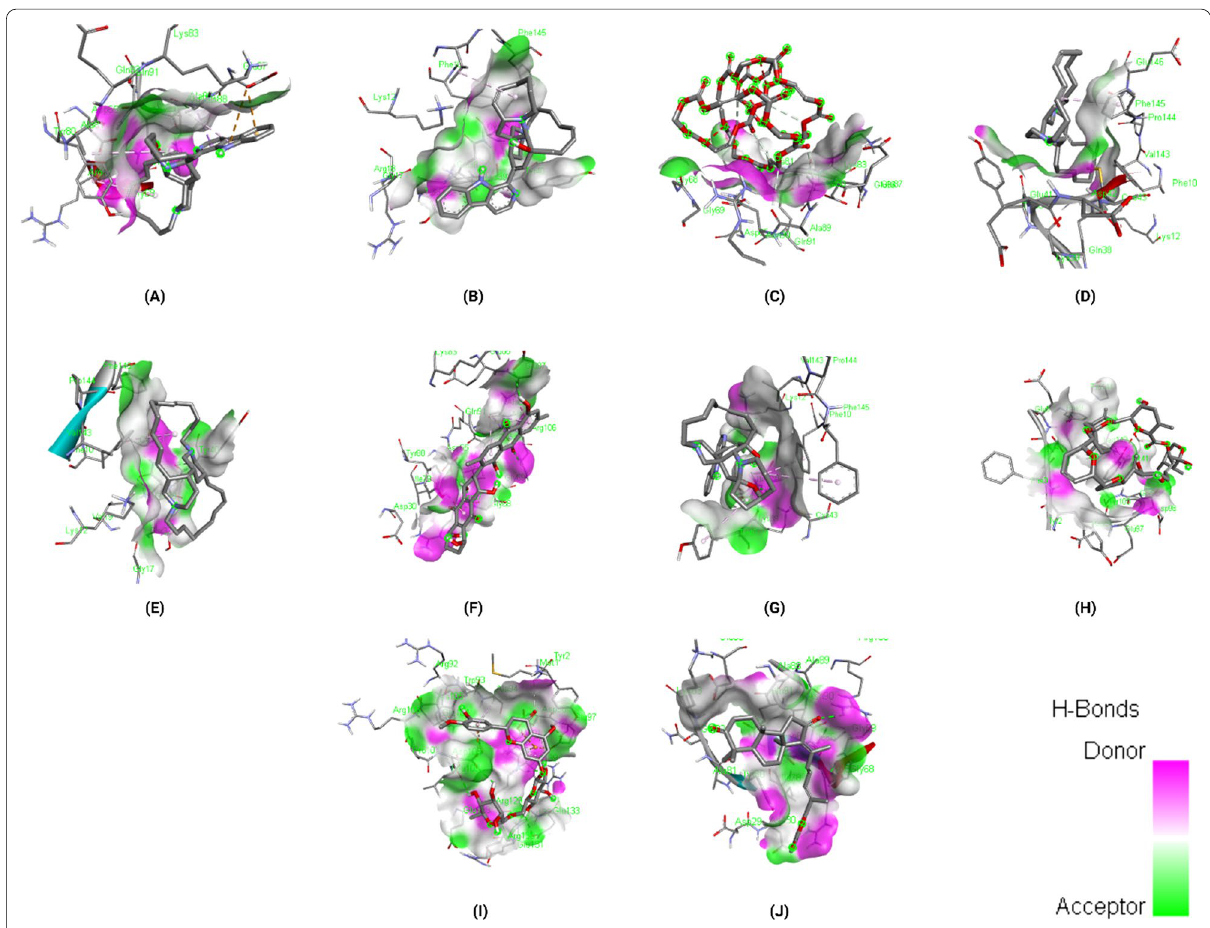
Fig. 8 3D visualisation of docking analysis of Mucoricin binding with 12,28-oxamanzamine A ( a ), manzamine A ( b ), parsiguine ( c ), halicyclamine A ( d ), tetrahydrohaliclonacyclamine A ( e ), Phaeosphenone ( f ), 6-deoxymanzamine X ( g ), goniodomin A ( h ), hesperidin ( i ), stelletin A ( j